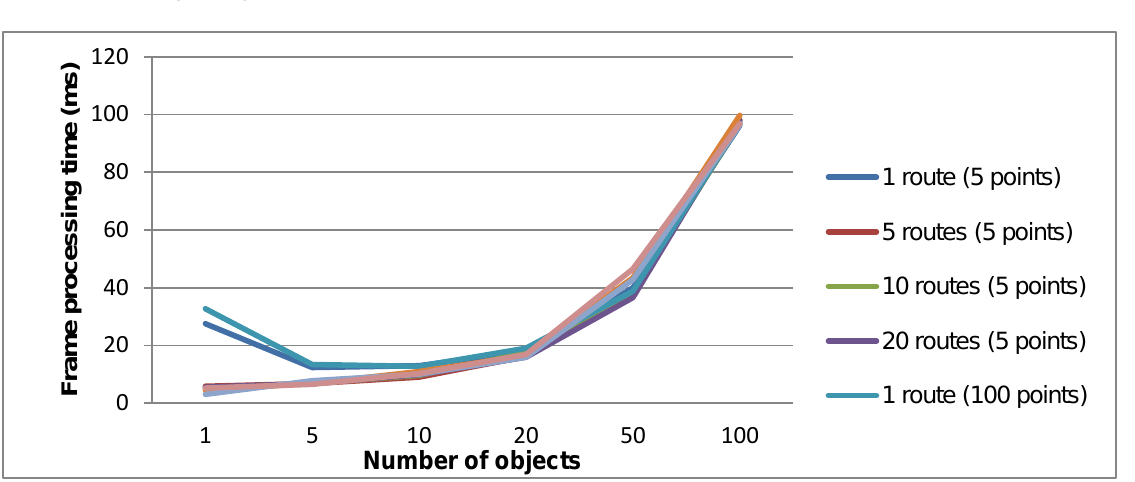
Figure 10. Frame processing time against number of objects and routes in the image and points-per-trajectory